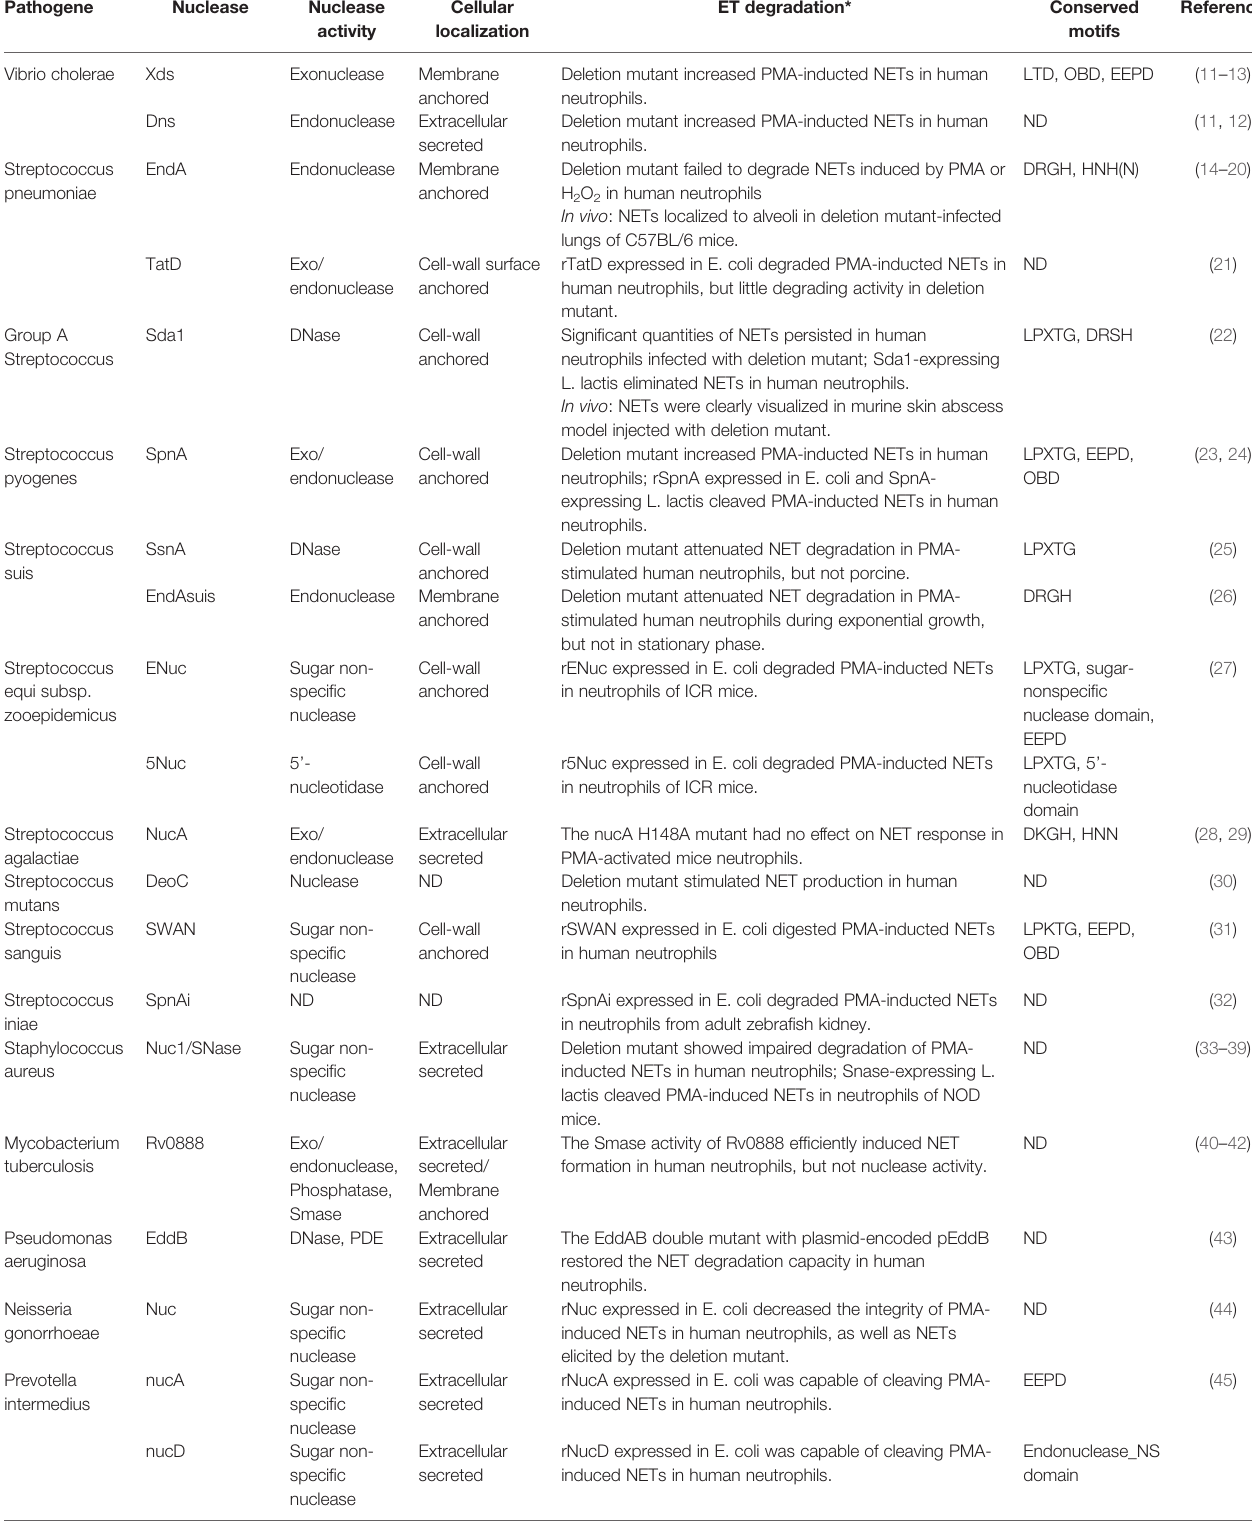
TABLE 1 | Pathogen-derived nucleases that degrade